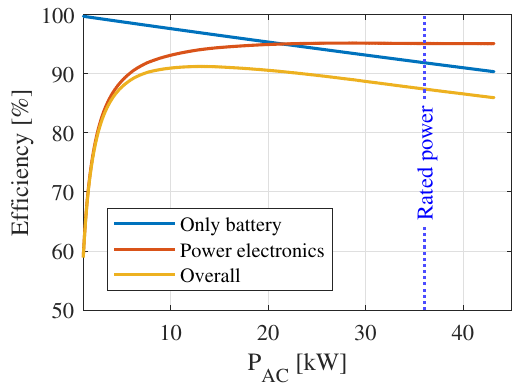
Figure 4. Round-trip efficiency values for battery, power electronics, and overall